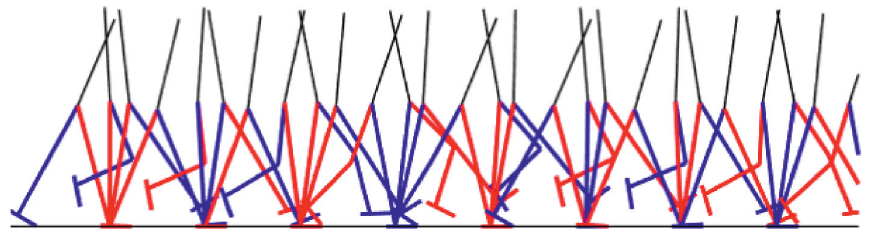
� 2 . 4and u � 22. e s